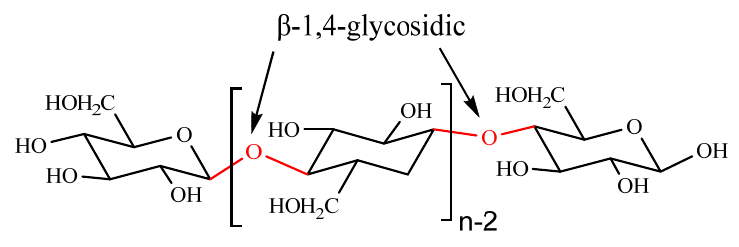
Figure 8. Structure of cellulose.